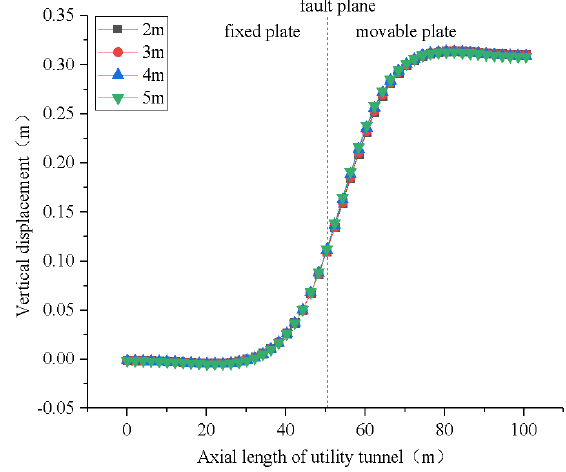
Figure 10. Vertical displacement distribution curve.